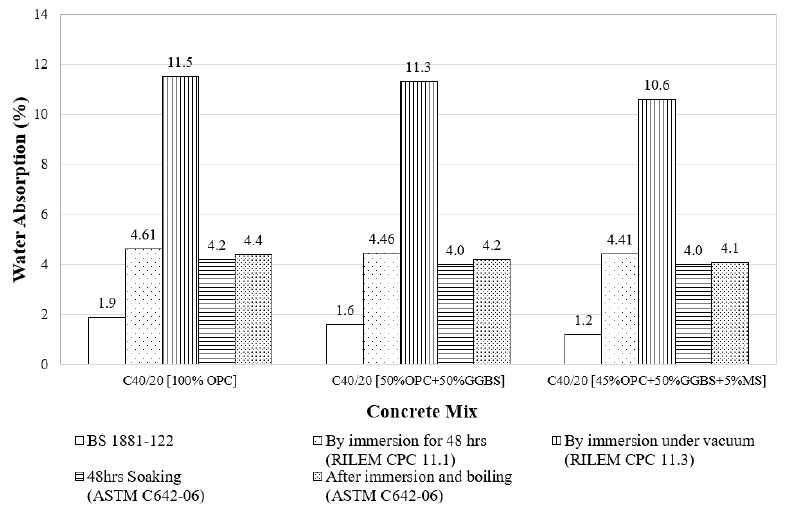
Figure 4. Porosity of concrete obtained in terms of water absorption by various test methods.